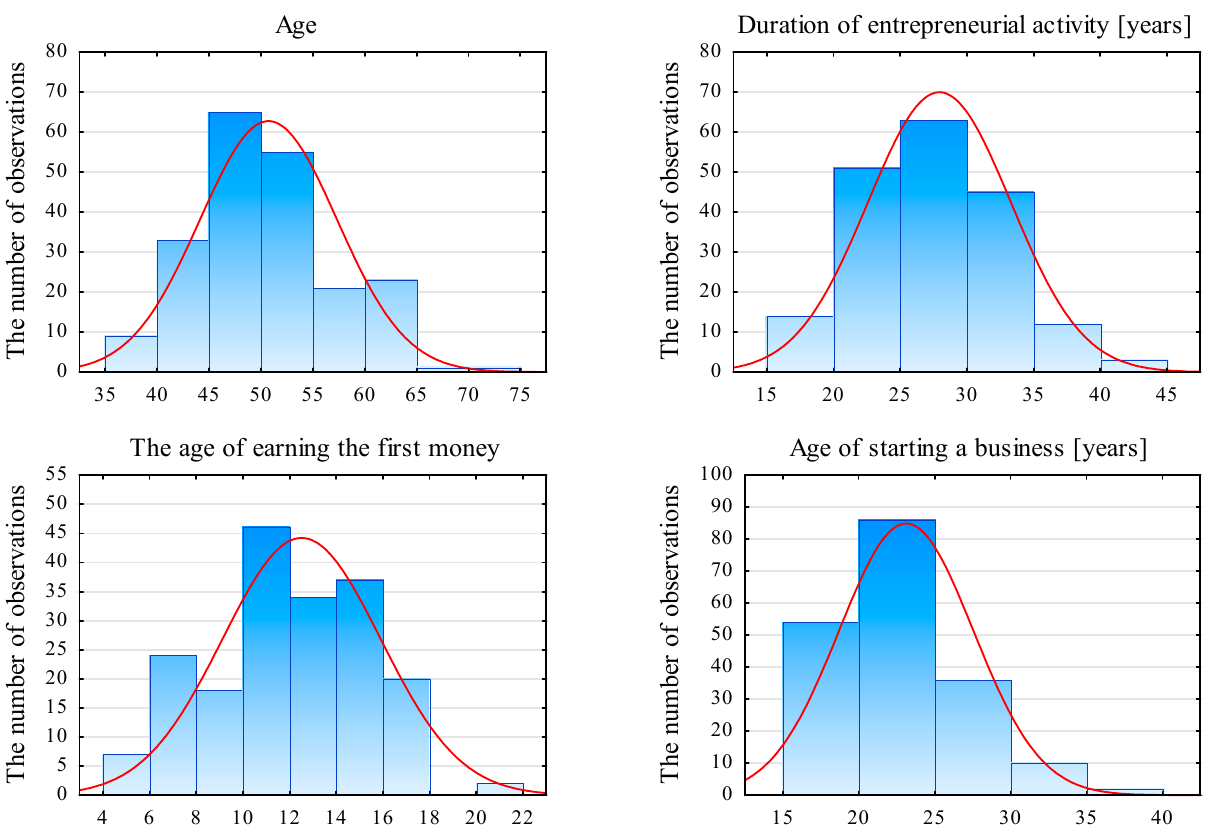
Figure 1. Research sample group metrics (Appendix B).